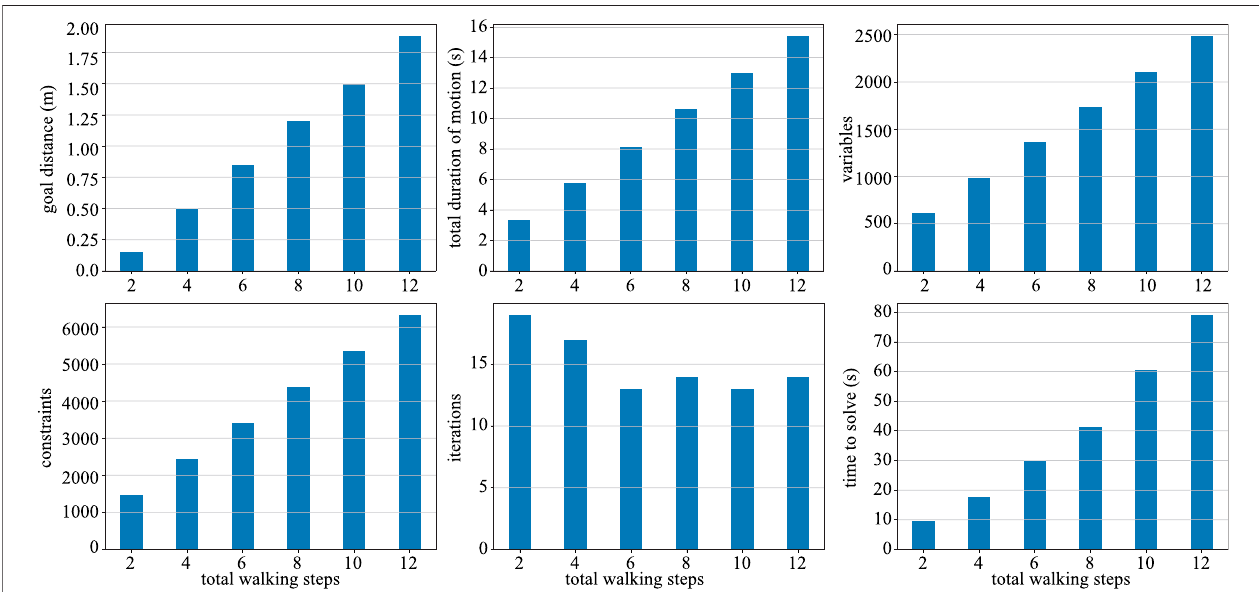
FIGURE 8 | Complexity analysis for TOWR+ is shown here for six different forward walking behaviors each de fi ned with a different speci fi cation. As the complexity oftheproblemincreaseslinearly(i.e.,thegoaldistance,totalduration,andnumberofsteps),thenumberofdecisionvariablesandconstraintsincreaseslinearly,whilethe wall-clock time to solve the problem increases almost linearly.